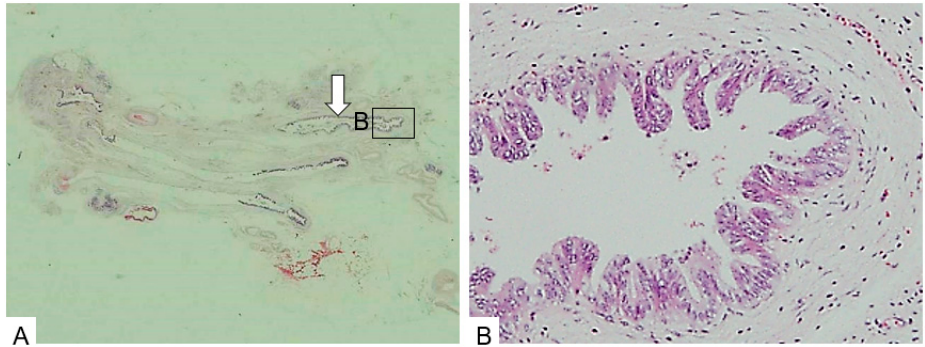
Figure 8. Dilation type. ( A ). The pancreatic parenchyma is severely atrophic and replaced by fat.